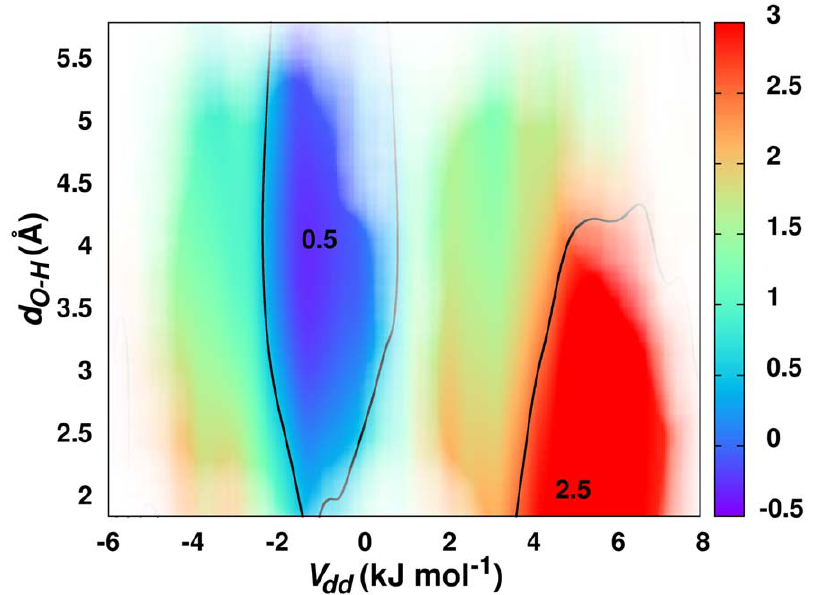
Figure 3. Carbonyl 13 C Chemical Shifts and Hydrogen Bonds. Contour plot of 13 C carbonyl chemical shift differences as a function of calculated dipole-dipole potential ( V dd ) and calculated hydrogen bond length ( d O { H ). See also Figure S2.